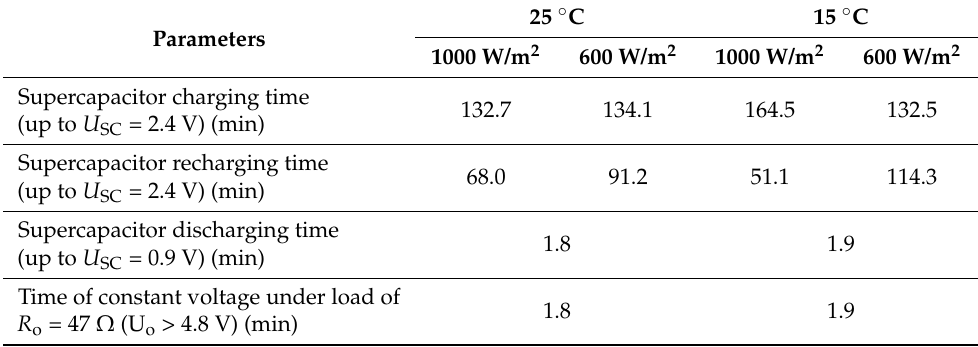
Table 2. Selected electrical parameters of investigated energy storage system under different labora- tory conditions.